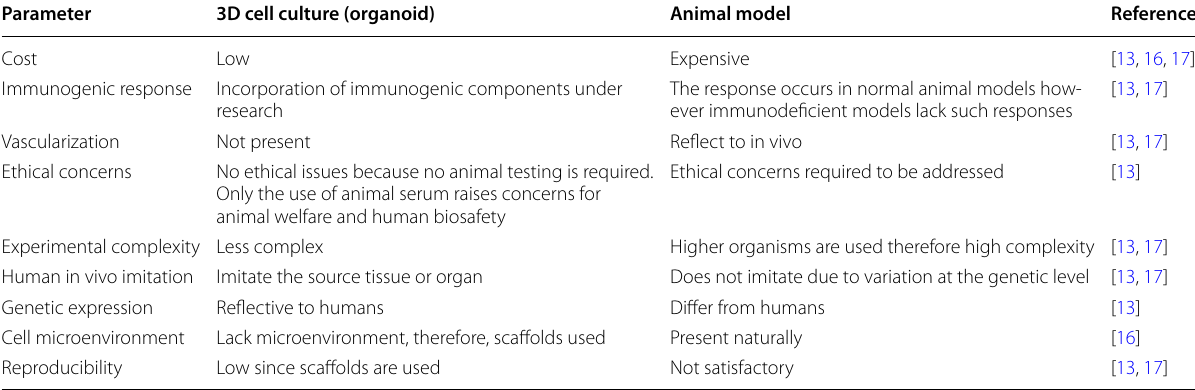
Table 2 Comparative study of 3D cell culture over animal